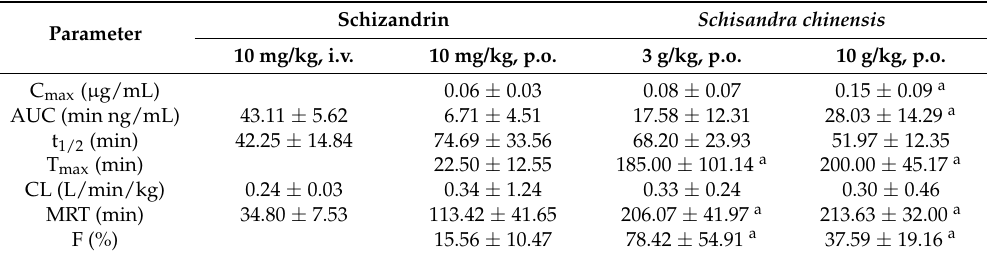
Table 4. Pharmacokinetic parameters of schizandrin in rat plasma.